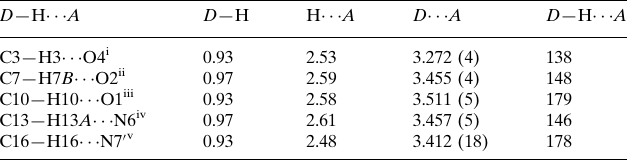
Hydrogen-bond geometry (A˚ , (cid:2)